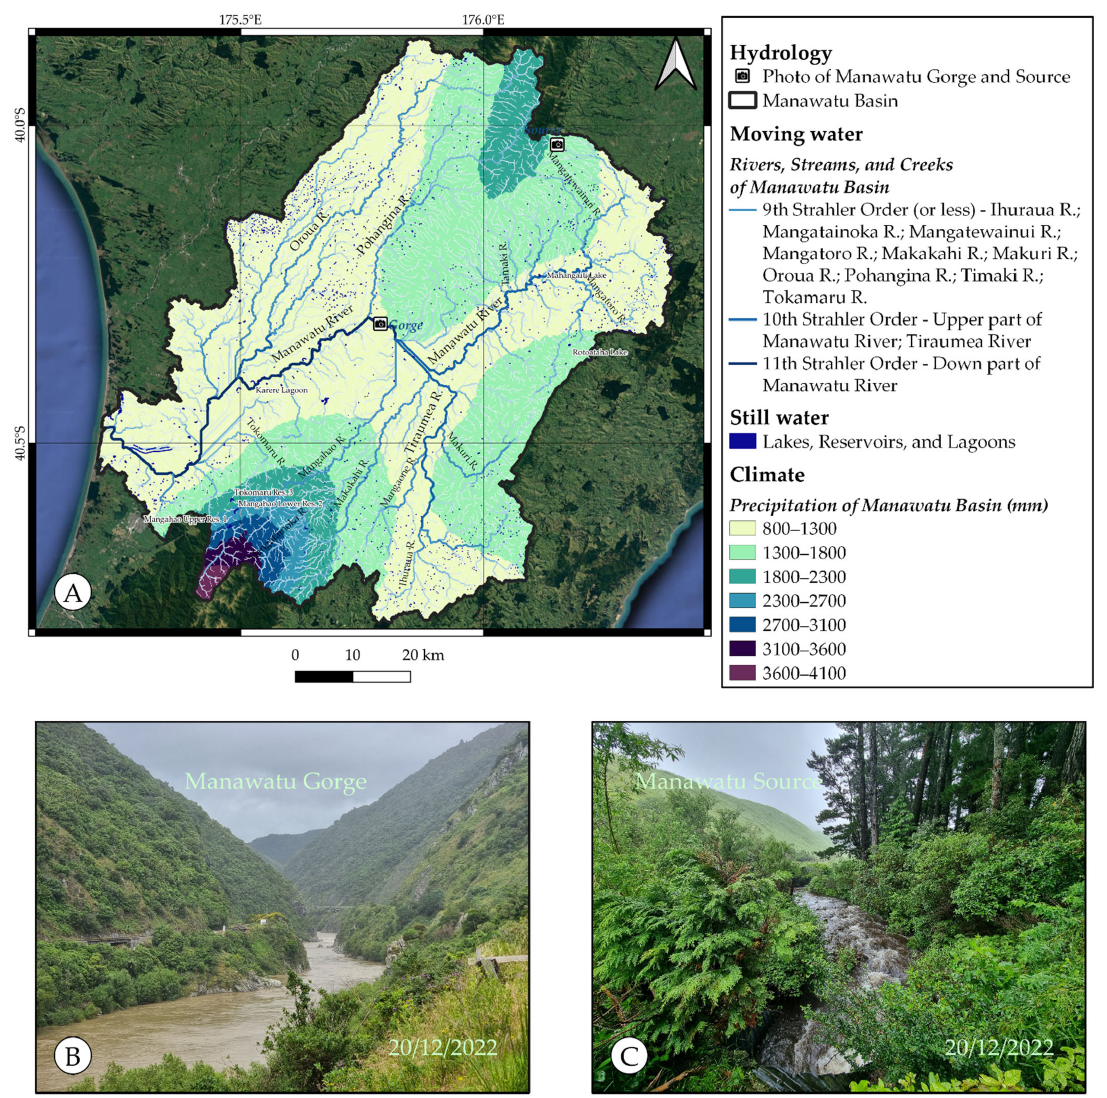
Figure 3. ( A ) Hydrological model of Manawatu Basin based on channels model extracted from Shut- tle Radar Topography Mission (SRTM) 1 Arc-Second Global